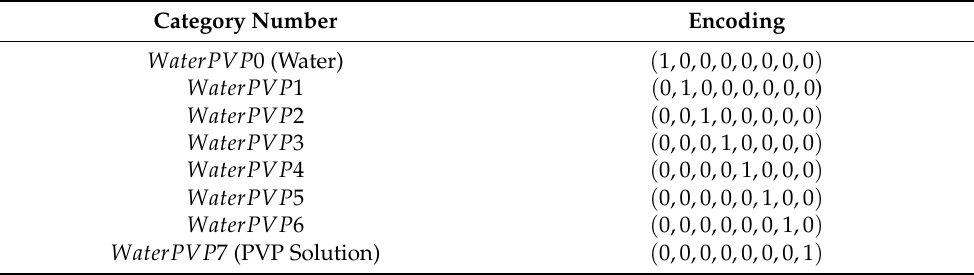
Table 4. One-Hot encoding of the target